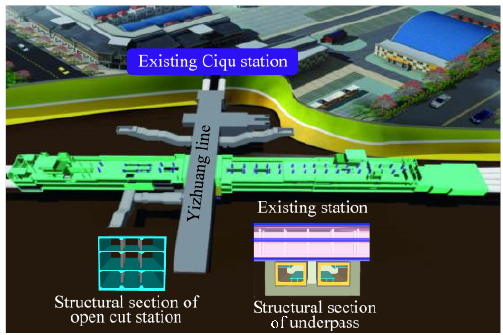
Figure 1. General layout of secondary Ciqu stations.